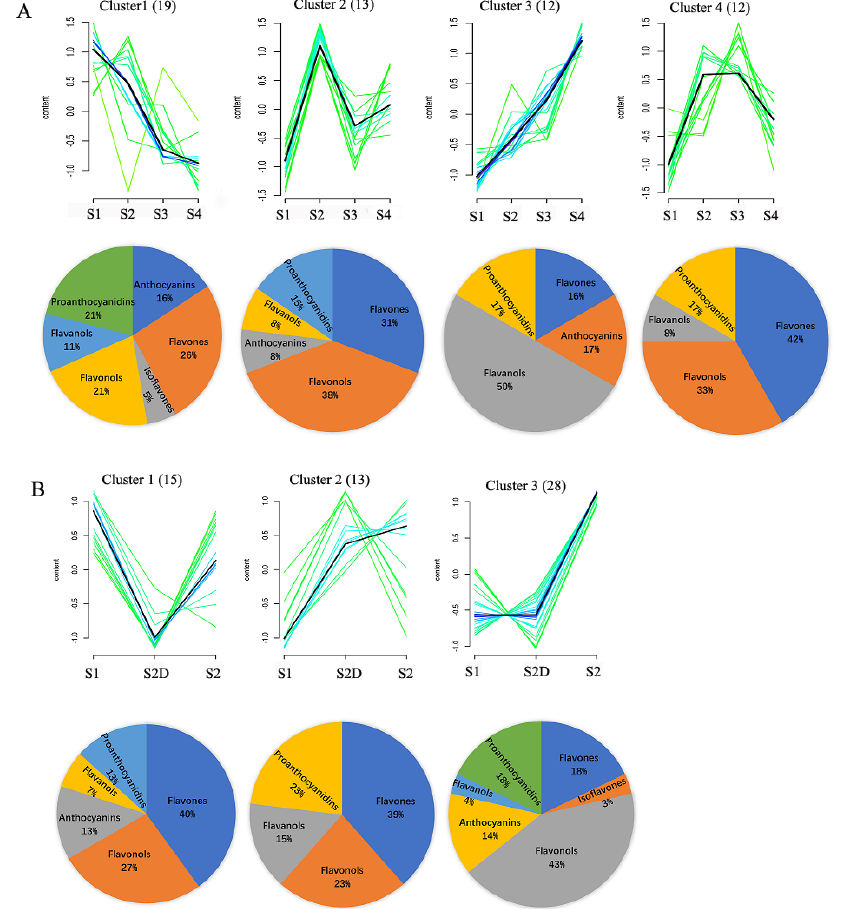
Figure 6. Sequence chart of differential metabolites in developing rose flowers and the ratio of metabolic groups for each cluster depicted above. ( A ) Rose flowers from S1 to S4 under natural light condition and ( B ) rose flowers from S1, S2D and S2.